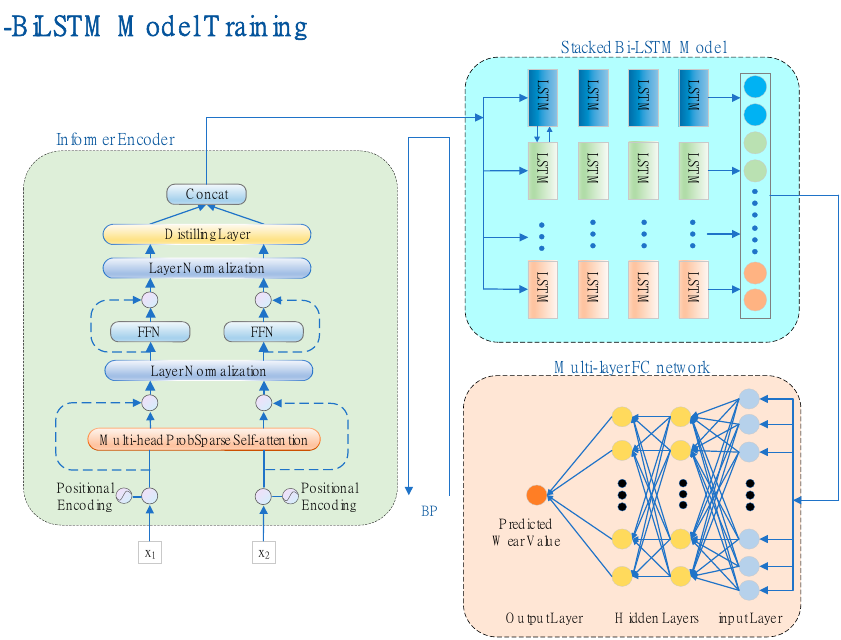
Figure 8. Illustration of the proposed method.